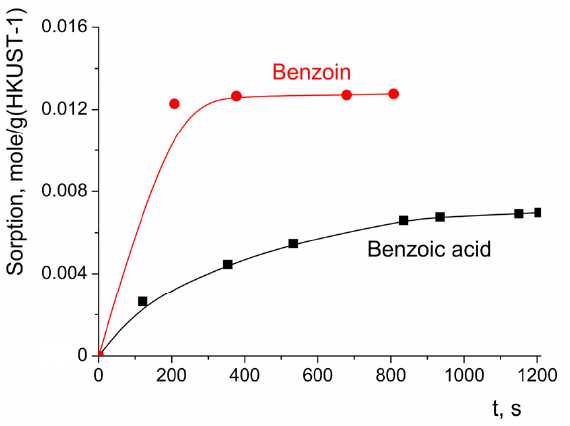
Figure 11. Dependency of benzoin and benzoic acid sorption on HKUST-1 on time. c 0 (benzoin) = 0.0165 M; c 0 (benzoic acid) = 0.0165 M.